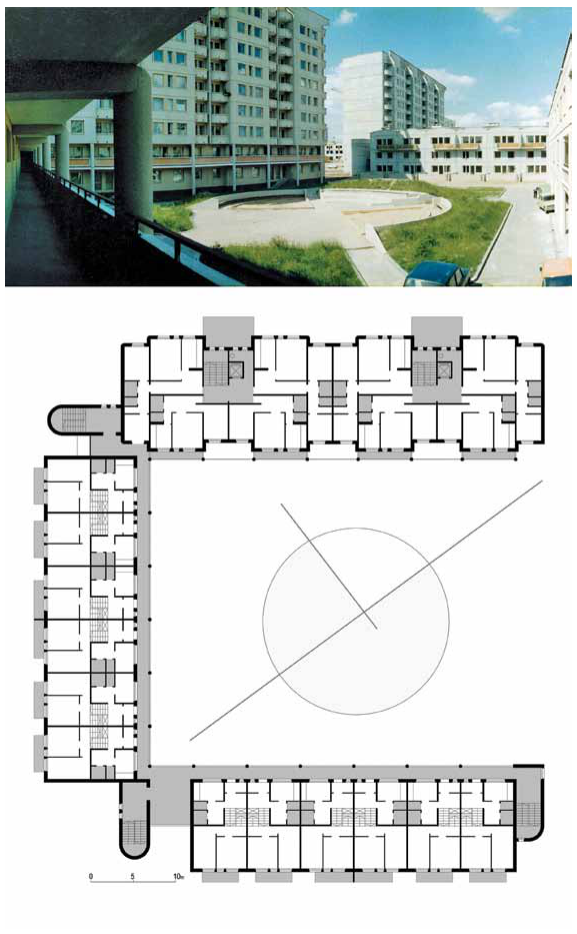
Fig. 15. apartment blocks complex in residential district IV of Pašilaičiai: view from the courtyard, layout of the building (archit. Danas ruseckas, Irena Maknienė, contr. st. in 1986 )